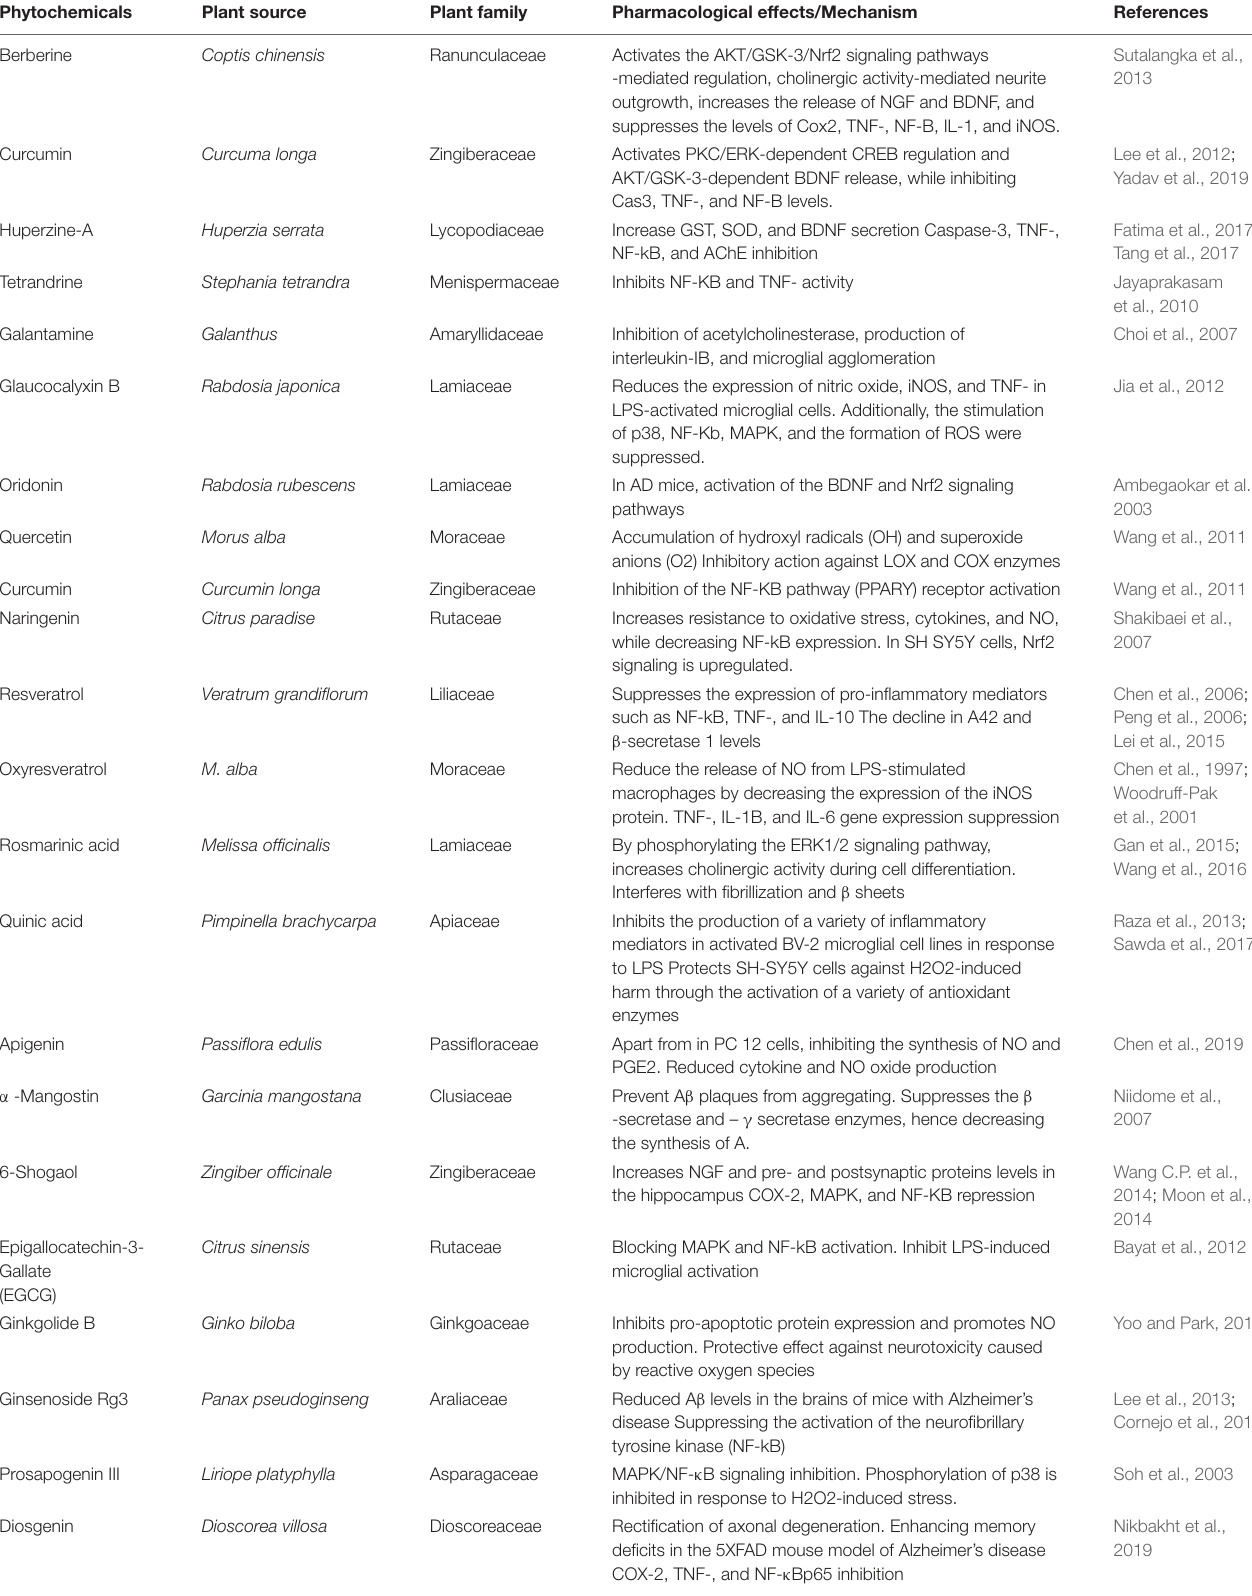
TABLE 3 | Plant-derived phytochemicals that affect Alzheimer’s